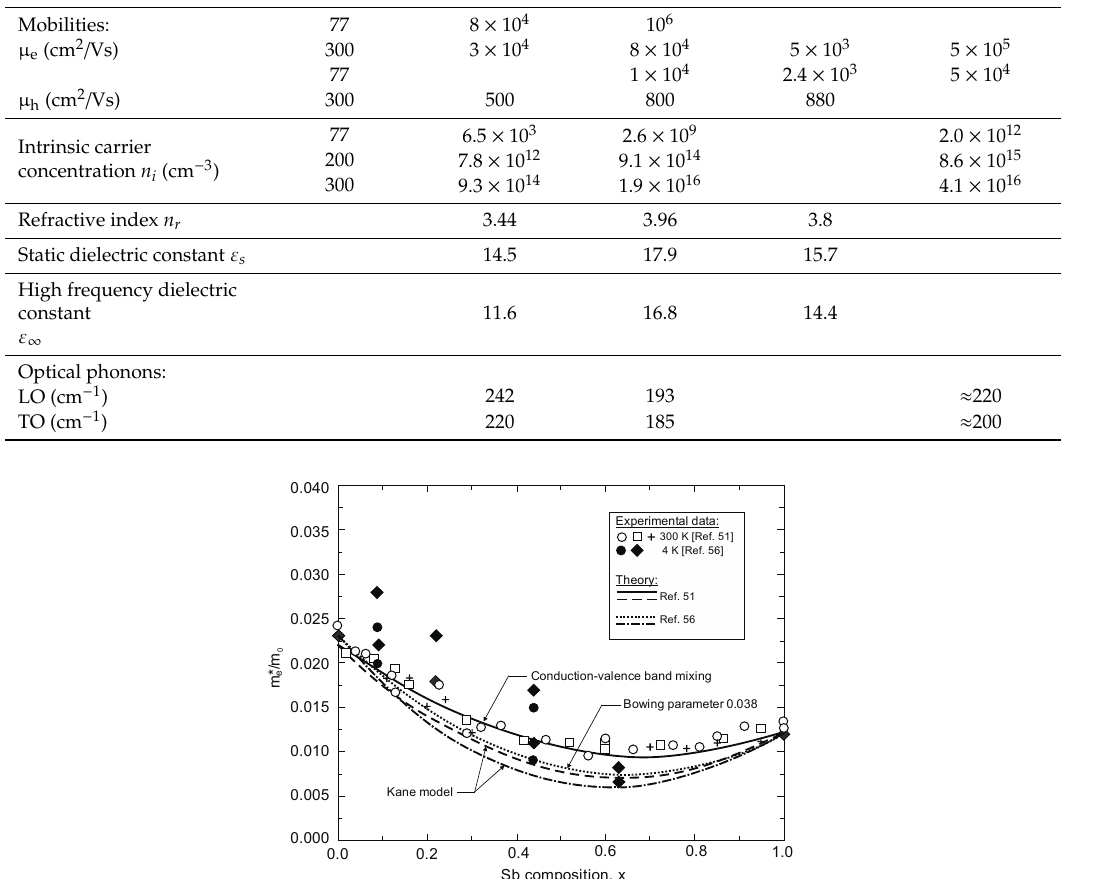
Figure 10. Effective mass of electron versus composition for InAs 1–x Sb x . The experimental data is taken Figure 10. E ff ective mass of electron versus composition for InAs 1 − x Sb x . The experimental data is from [51,56]. taken from